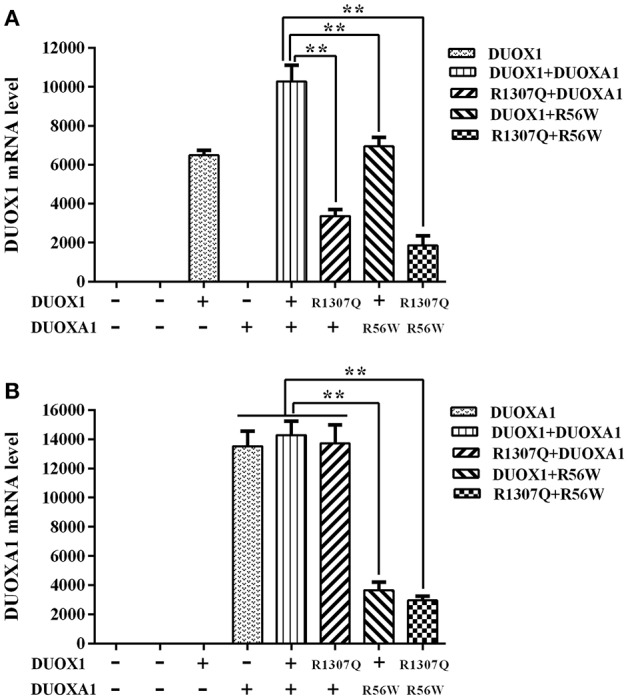
Relative mRNA expression levels under the various indicated vector transfections. (A)
DUOX1 mRNA expression. The DUOX1 mRNA level was highest in the group with both wild-type DUOX1 and DUOXA1 expression vectors, while the group with p.R1307Q and p.R56W combination had the least mRNA expression of the DUOX1 gene compared with other experimental groups except for the group with DUOXA1 only. (B)
DUOXA1 mRNA expression. Groups with p.R56W mutant were far lower than other experimental groups with DUOXA1. Each column represents the mean ± SD of three independent experiments performed in triplicate. **P < 0.01.